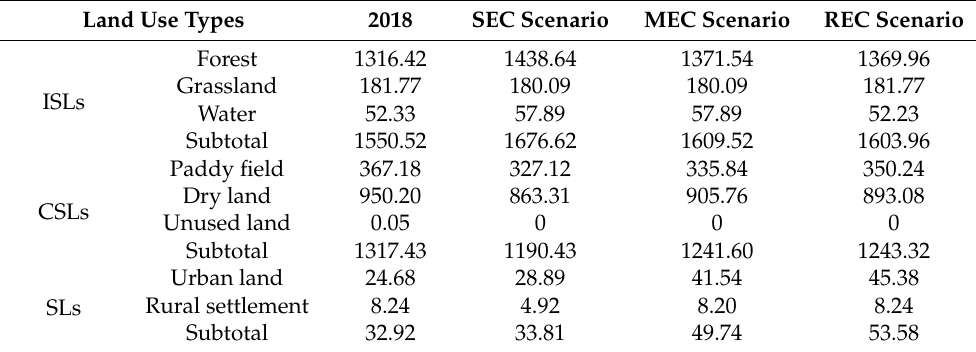
Table 4. Optimization of the area of each land use type in Fengdu County under different scenarios (unit: km 2